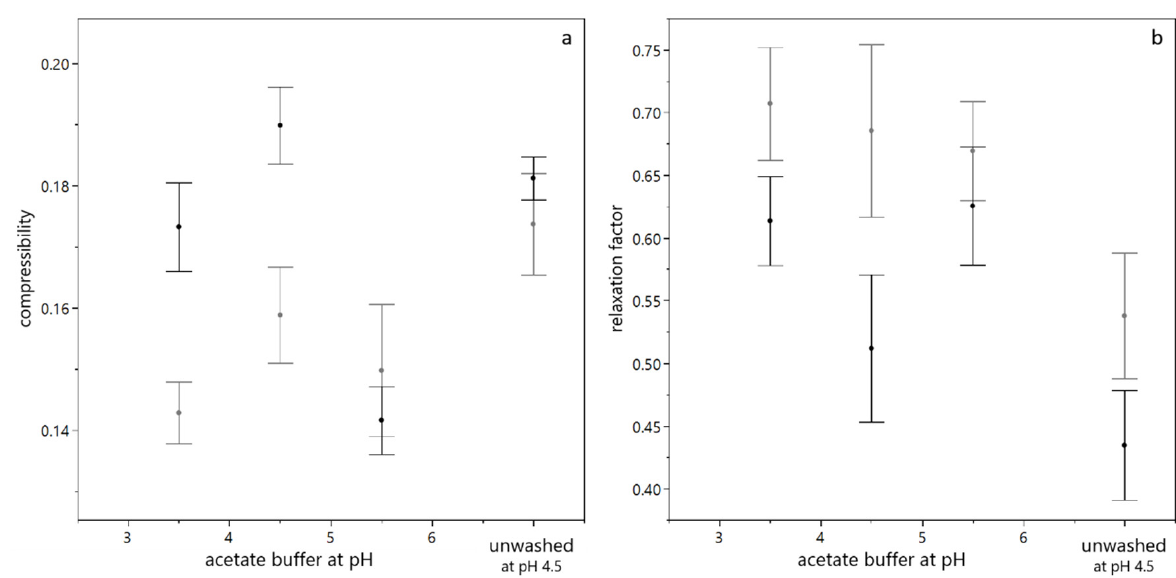
Figure 8. Compression behavior of yeast suspensions with (grey) and without (black) BSA present. The compressibility is given for different buffer pH, where the error bars indicate the standard deviation from fitting the model equation ( a ). The relaxation behavior of the sediments is given for different buffer pH, where the error bars indicate the standard error over all values from different centrifugal acceleration and a duplicate measurement ( b ).